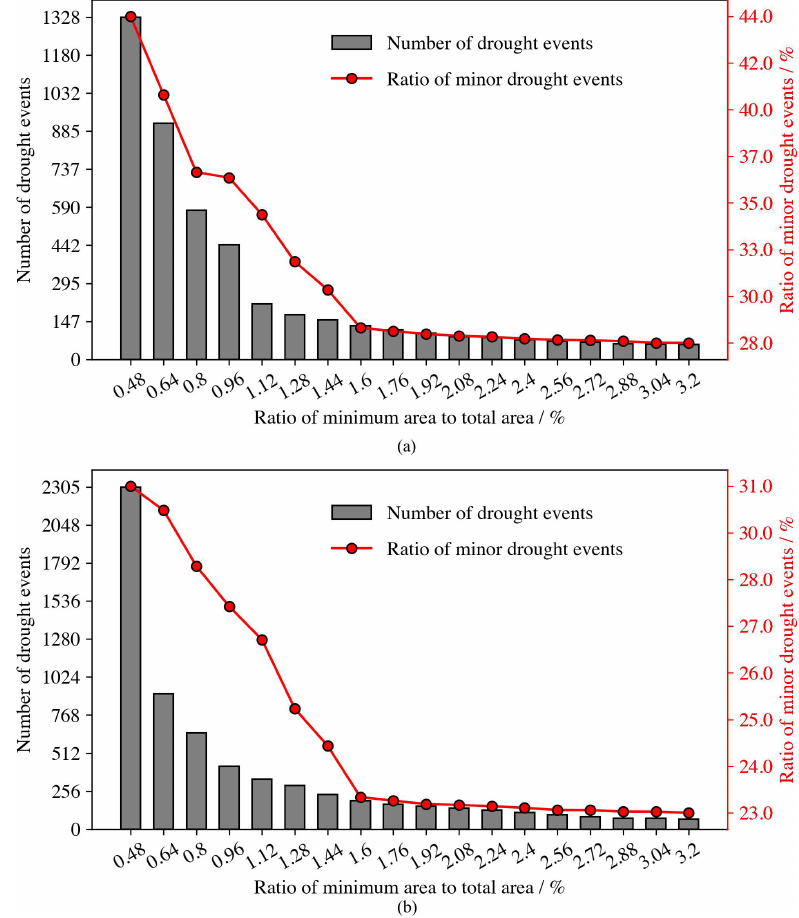
Figure 3. Sensitivity test of overlapping areas of drought patches between two adjacent